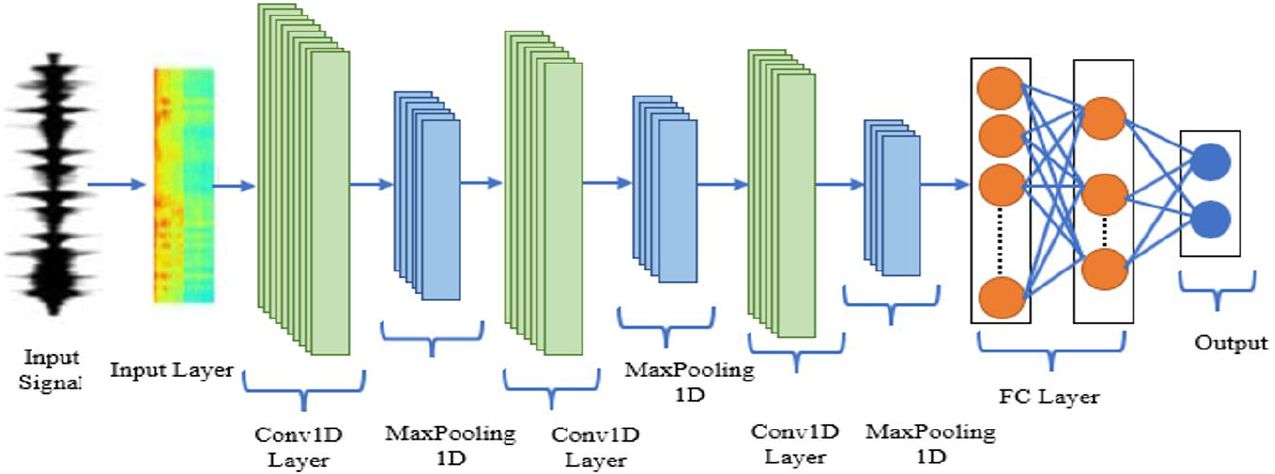
Figure 3. The basic structure of 1D-CNN.